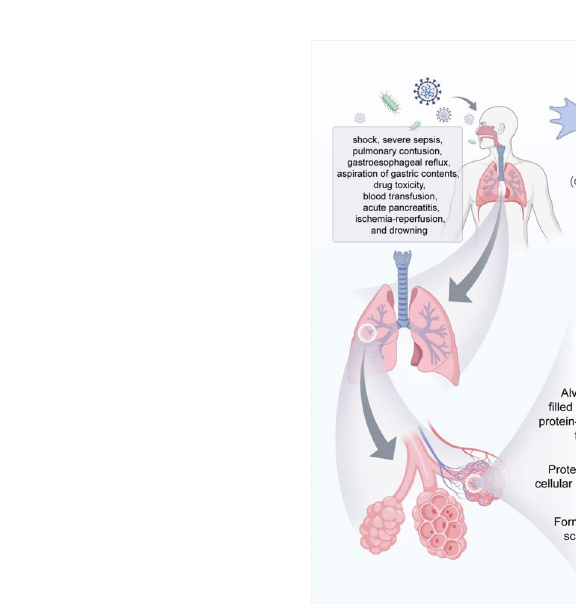
shown in Figure 3 . The endosomal sorting complex required for transport plays a key role in exosome biogenesis (97). The density of exosomes is approximately 1.13 – 1.19 g/ml, and exosomes are widely found in plasma, serum, urine, BALF, breast milk, saliva, tears, ascites, and other body fl uids (98 –